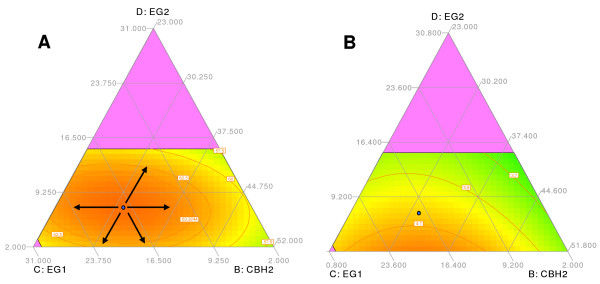
Ternary plot showing predicted final yield (a) and initial conversion (b) as a function of CBH2, EG1 and EG2 content. Proportions of the other enzymes were fixed according to point 28 (CBH1 = 38.2%, Cel74a = 0% and XYN1 = 6%). The blue point shows the position of point 28 and arrows indicate variations of component ratios as discussed in the text.